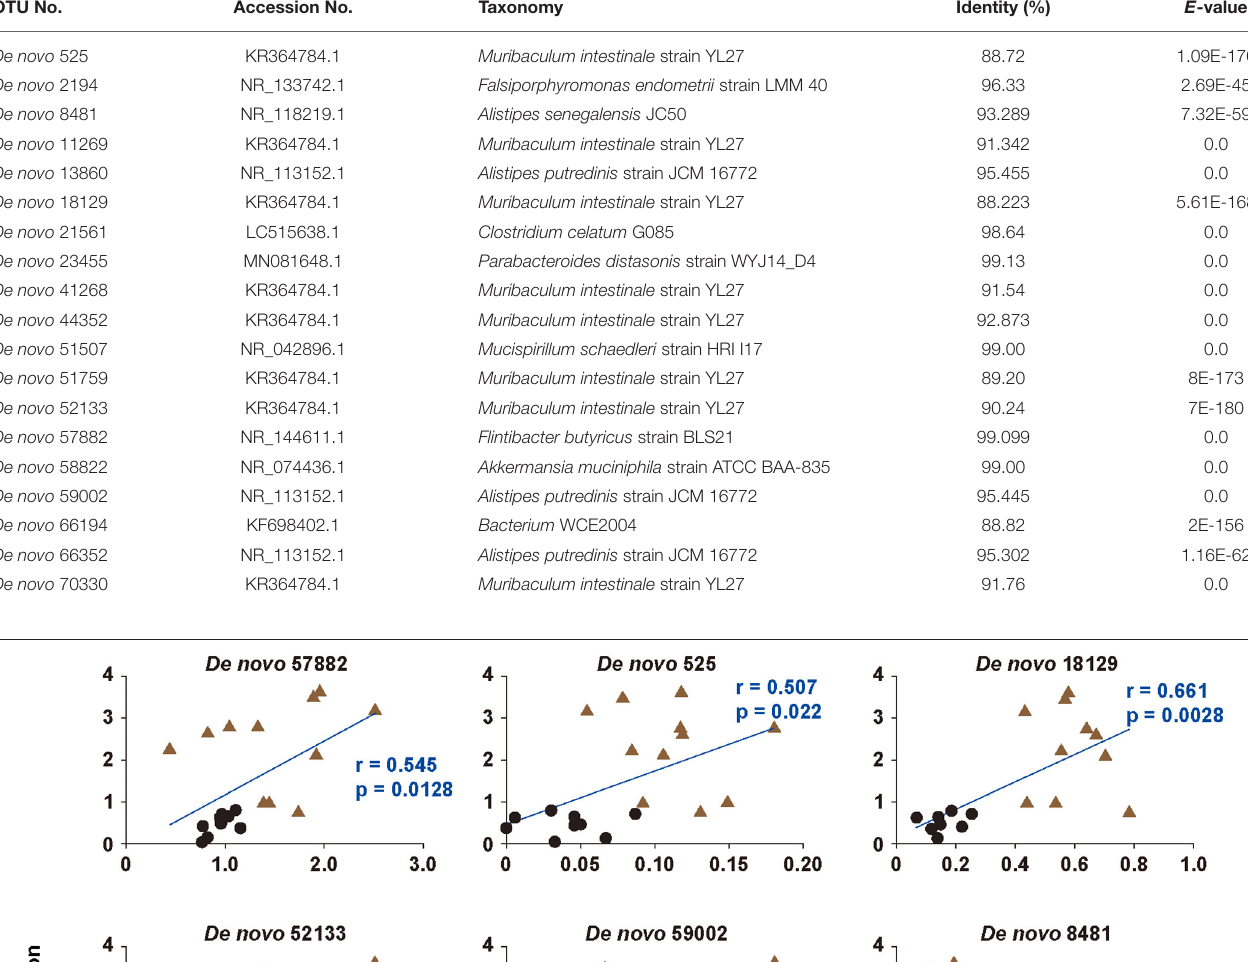
TABLE 2 | Characteristics of 19 OTUs in the cecal contents. OTU No.